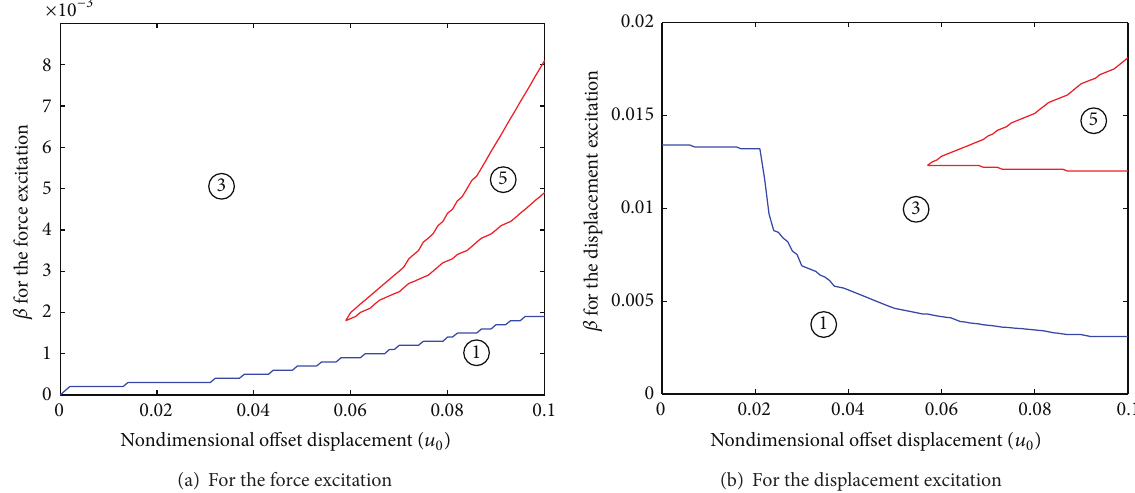
Figure 9: The maximum number of the steady-state solutions: one, three, or five, as a function of the offset displacement ̂𝑢 0 and the excitation amplitude 𝜌 for the optimal configurative parameters and 𝜉 = 0.03